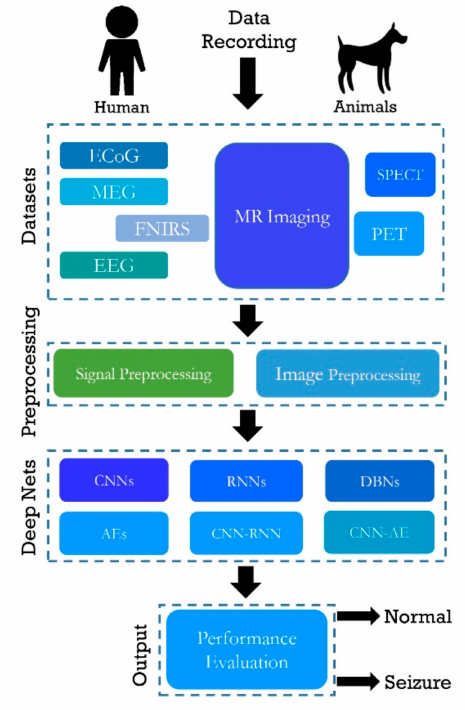
Figure 4. Block diagram of a DL-based CAD system for epileptic